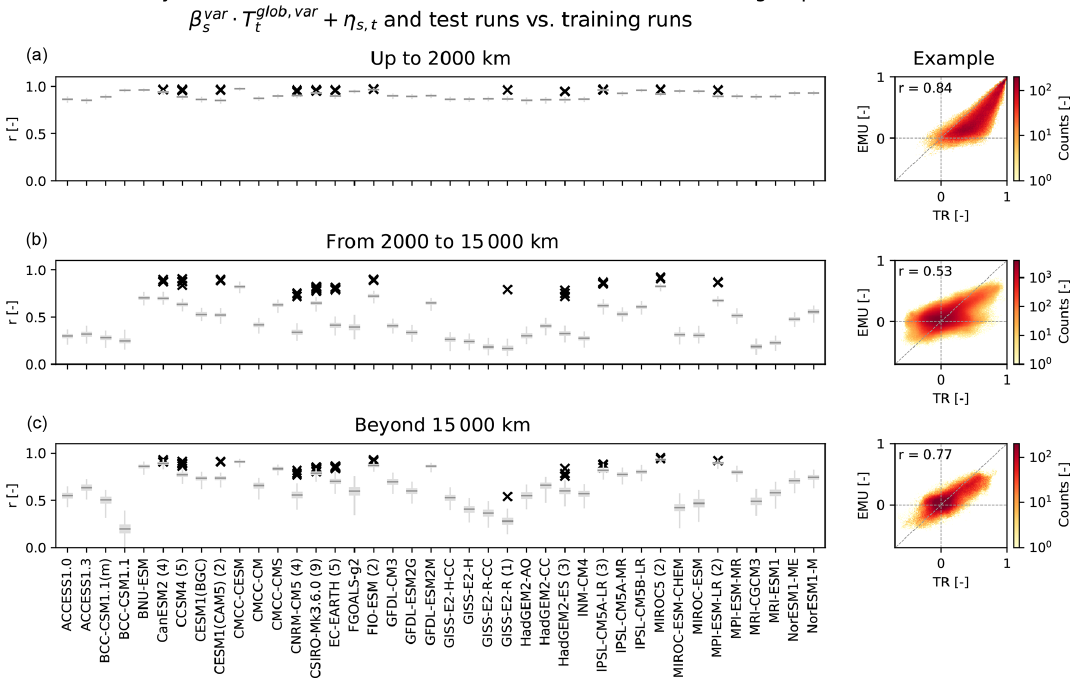
Figure 11. Local variability verification for the CMIP5 models (columns) by means of the Pearson correlation of cross-correlations between grid points in three geographical bands (rows) between the 1000 individual emulations and the training runs (box plots). The geographical bands cover distances below 2000km (a) , between 2000 and 15000km (b) , and beyond 15000km (c) . The examples show the associated 2-D histograms for a single emulation and the training run of CESM1(CAM5). For the CMIP5 models with test runs, the correlation between the quantity in the training run and in each individual test run is indicated by a black cross. For all climate models with test runs available, the number of test runs is given in brackets after the model